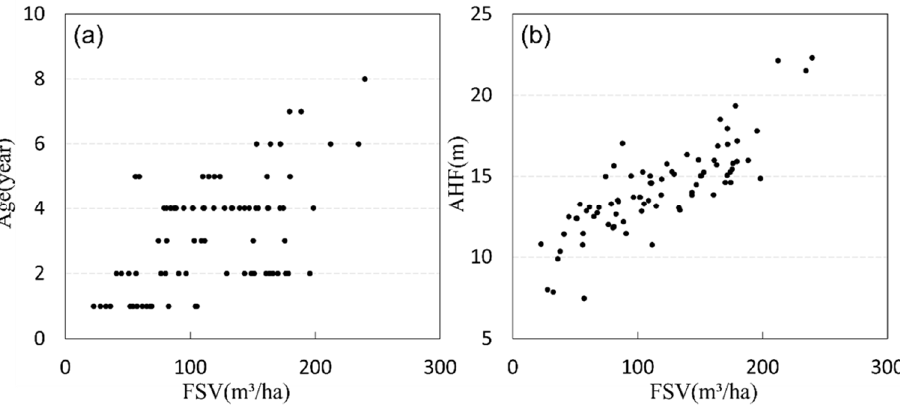
Figure 2. The relationship between AHF, age and FSV: ( a ) is the scatterplot of FSV and age; ( b ) is the scatterplot of FSV and AHF.